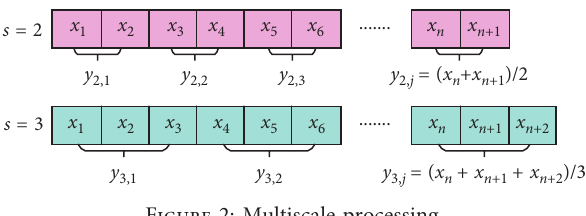
Figure 2: Multiscale processing.